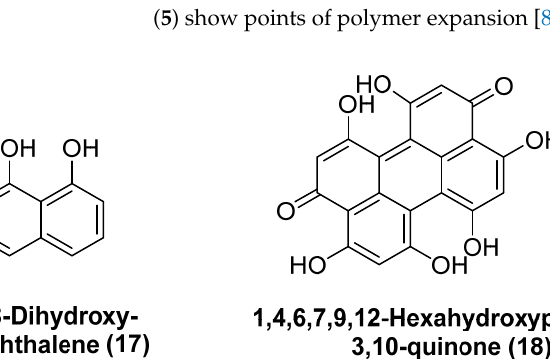
Figure 2. Structures and biosynthesis of eumelanin and pheomelanin. Arrows on structures ( 4 ) and ( 5 ) show points of polymer expansion [85,86].